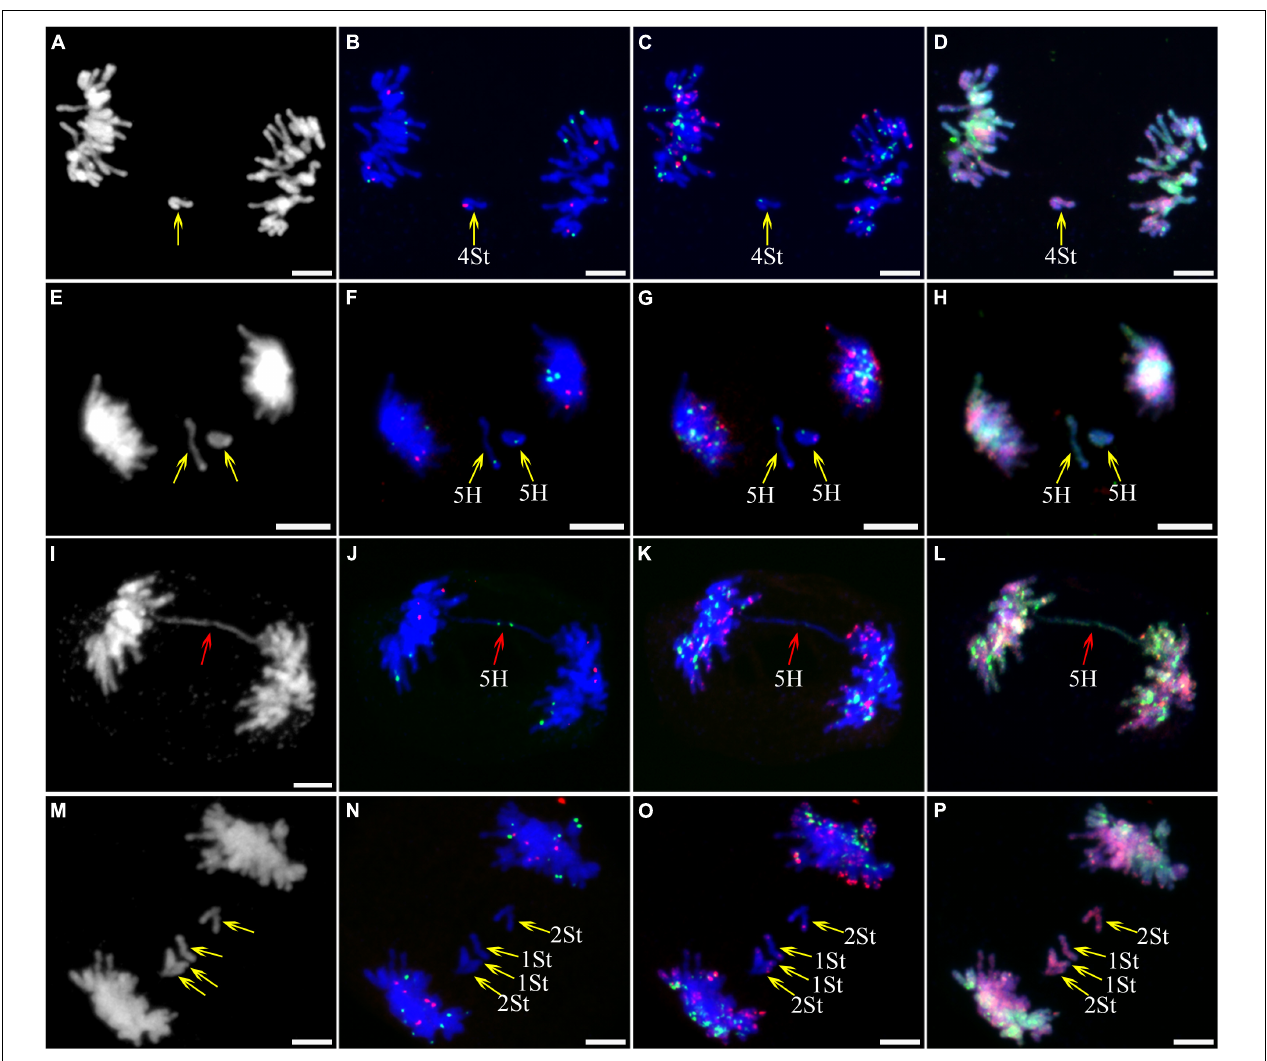
FIGURE 5 | Sequential fluorescence in situ hybridization (FISH) of meiotic ana-telophase II of plant A02-1 of E. nutans. (A,E,I,M) Chromosomes stained with DAPI; (B,F,J,N) pTa71-2 (red) and pSc119.2 (green); (C,G,K,O) pAs1 (red) and (AAG) 10 (green); (D,H,L,P) genomic DNA probes of P. stipifolia (red) and H. bogdanii (green). Yellow arrows: lagged chromosomes; red arrows: bridge. Bars = 10 µ